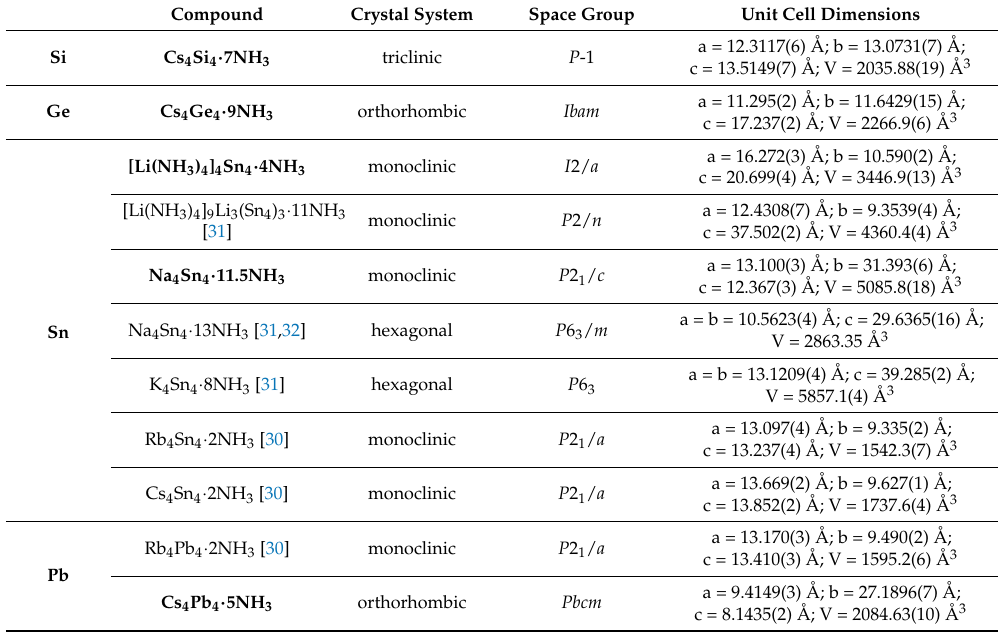
Table 2. Hitherto known A 4 E 4 · x NH 3 (A = Li-Cs; E = Si-Pb) solvate structures and selected crystal structure details. The bold marked new compounds are discussed in this